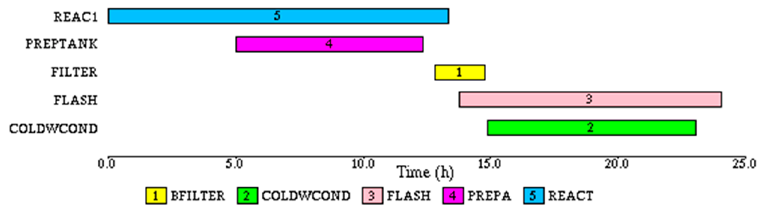
Figure 13. Gantt chart for the one-batch run.